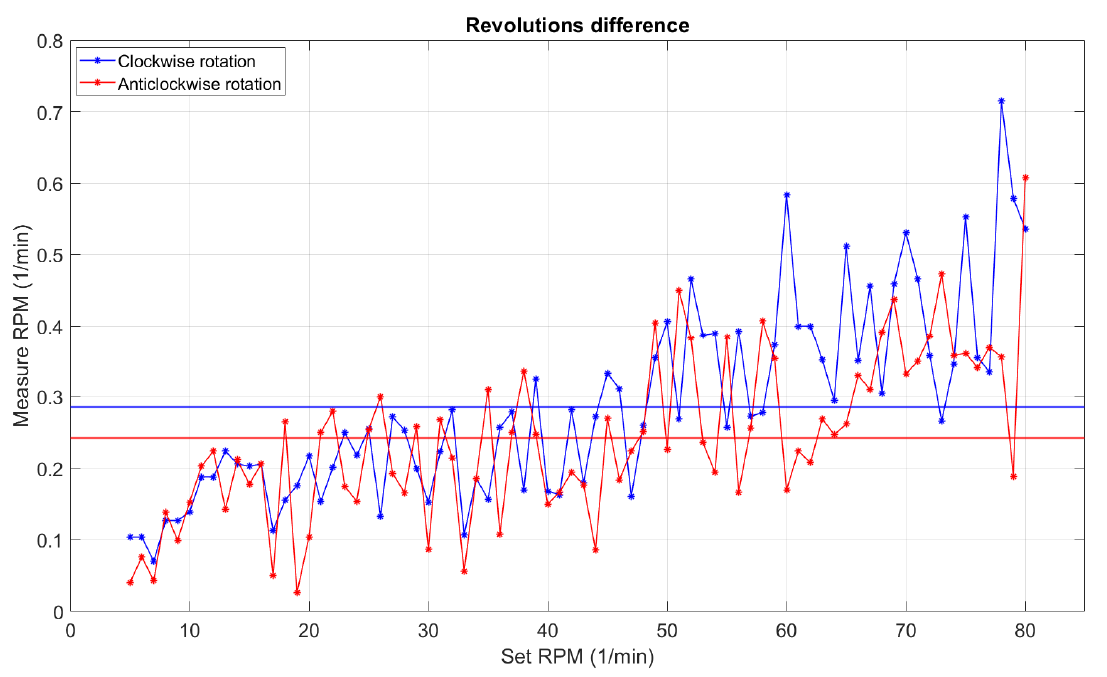
Figure 16. Plot of the values of differences between set and actual rpm; the straight line shows absolute error. Table 4. Absolute and relative errors of the differences between set and actual rpm before and after correction. Absolute Error Relative Error Before After Before After Clockwise directions 0.2813 RPM 0.2862 rpm 1.5% 0.80% Anticlockwise directions 0.6475 RPM 0.2419 rpm 1.93%